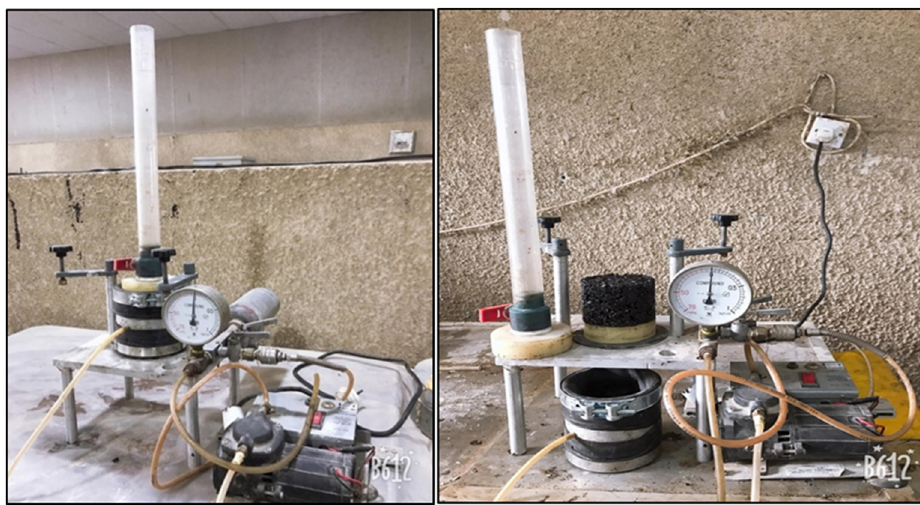
Figure 4: Hydraulic conductivity apparatus.